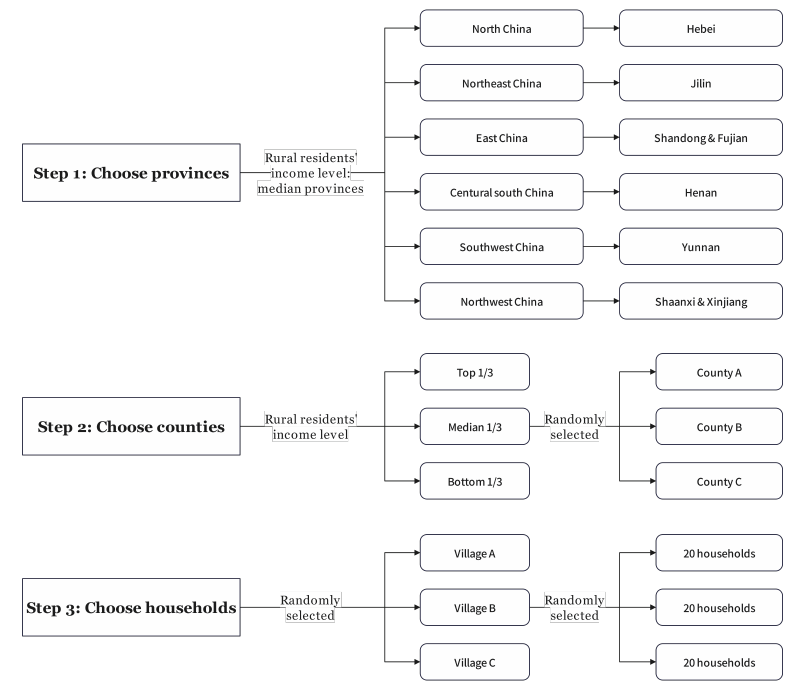
Figure 1. The sample selection process. Note: Nine counties were selected in